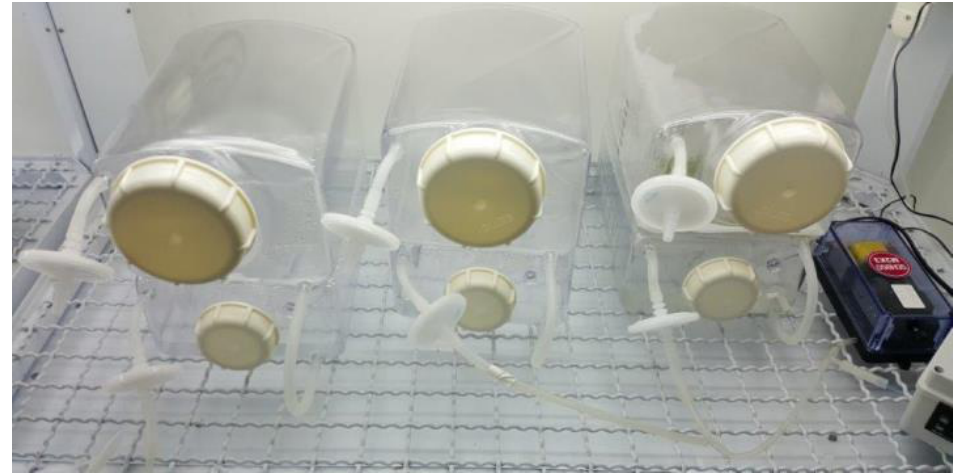
Figure 2. SETIS bioreactor TIS model consisting of two containers.